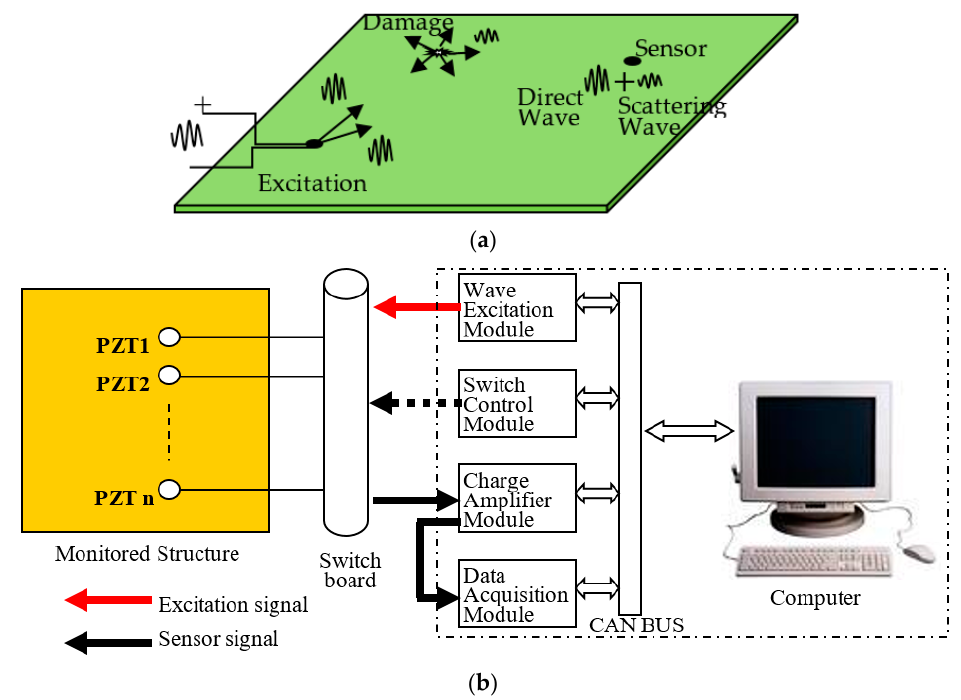
Figure 1. The active monitoring principle and the active monitoring system. ( a ) Schematic diagram of the active monitoring principle of a plate structure; ( b ) Structural diagram of an active Lamb wave based monitoring system.